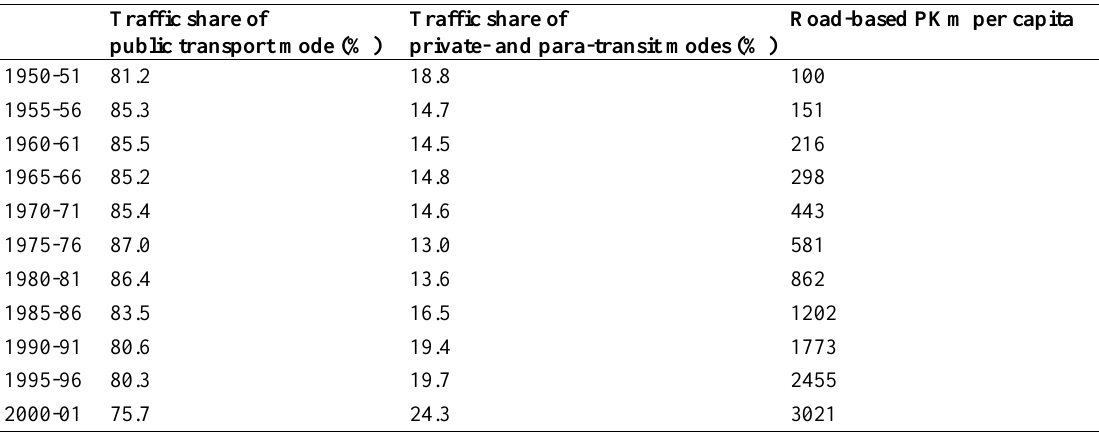
Table 4. Change in modal split from 1950-51 to